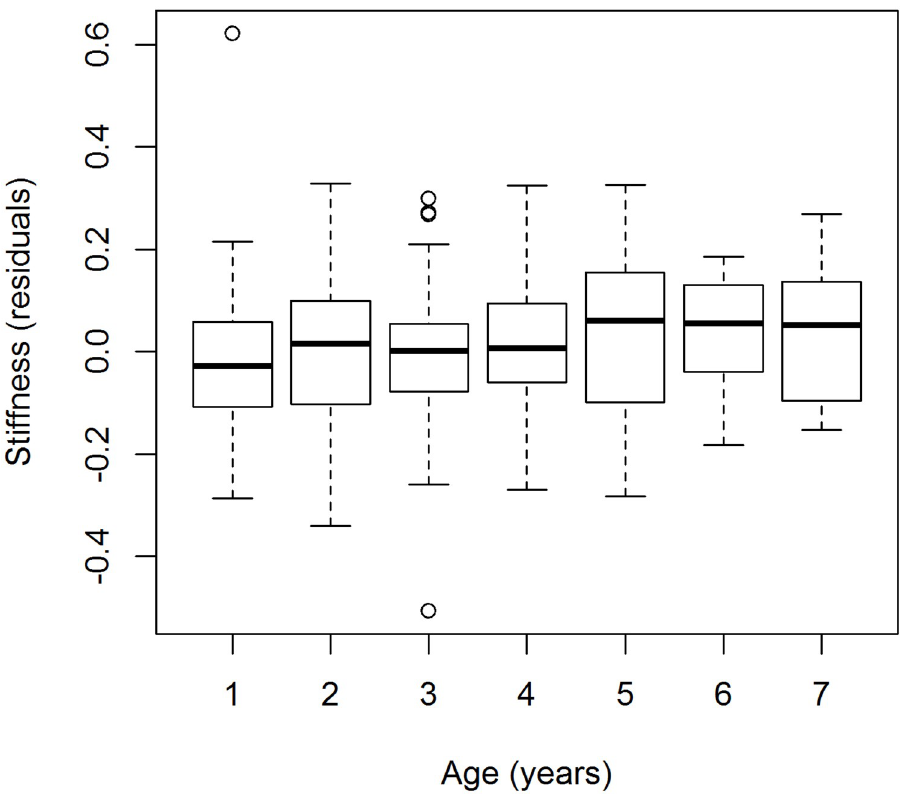
Fig 2. Bending stiffness of feathers of individual Sand Martins in different age categories. Residuals of the best model only consider within and between age, longitudinal size (PC1) and thickness (PC2) for bending stiffness (Model 16, Table 1). Box plots show medians, quartiles, data range (1.5 times the interquartile range) and extreme values.